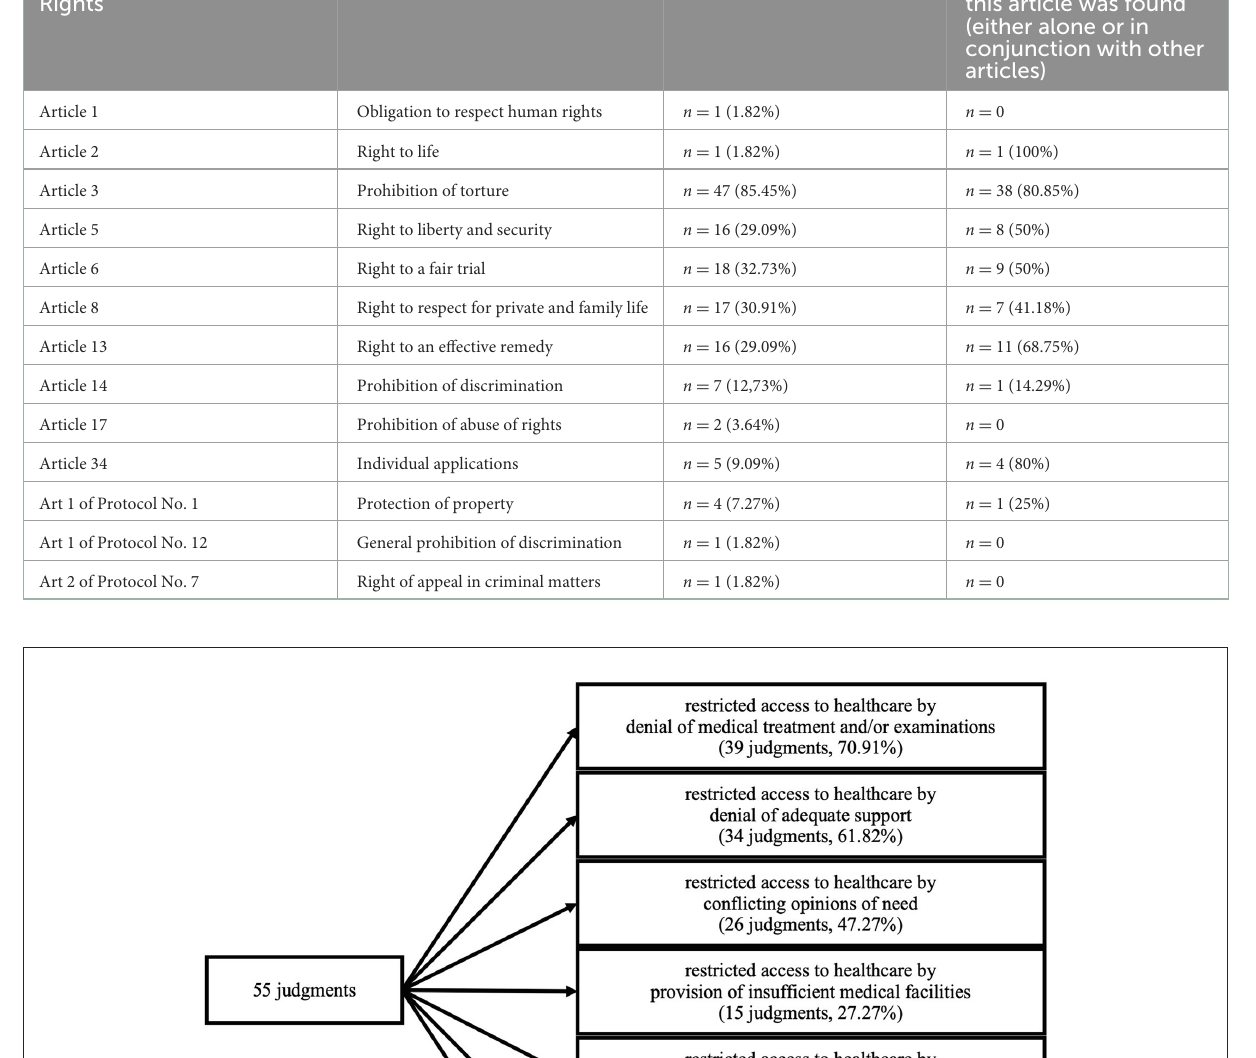
TABLE 2 Frequencies of articles on rights and freedom (Section 1, Articles 1–18) and protocols of the European Convention on Human Rights in the n = 55 judgments included into this analysis. Articles of the European Convention on Human